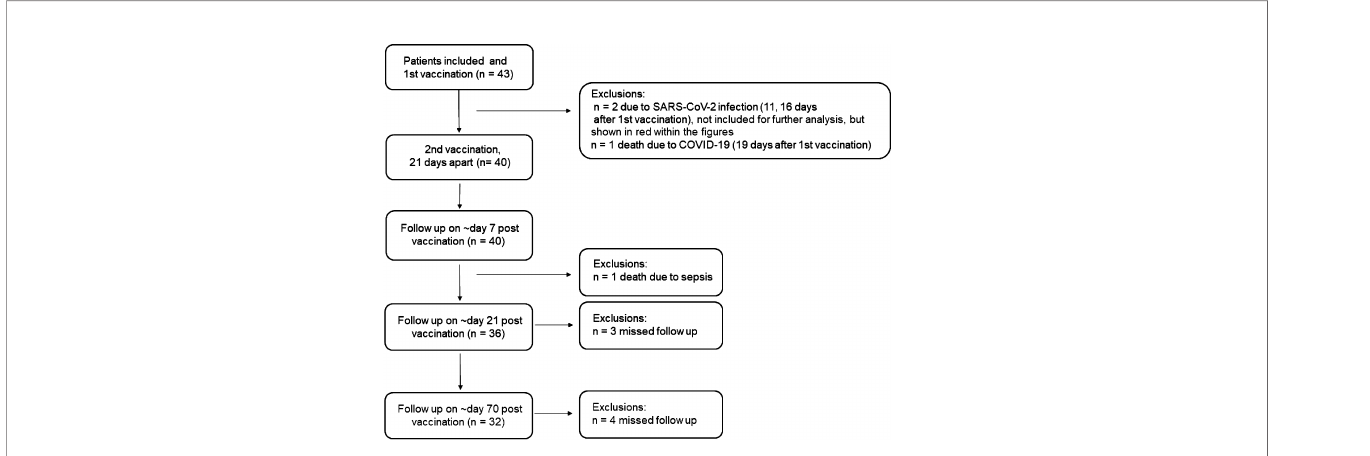
FIGURE 1 | Inclusion diagram dialysis